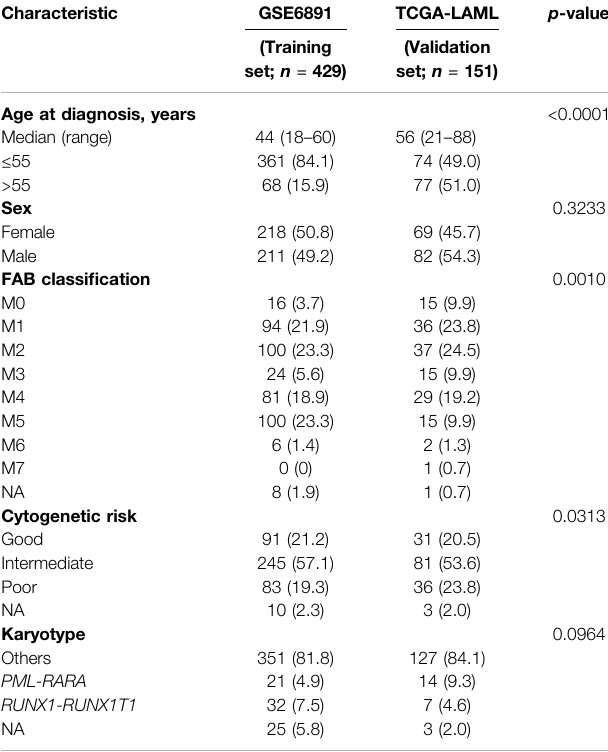
TABLE 1 | Characteristics of acute myeloid leukemia patients in the training set and the validation set. Characteristic